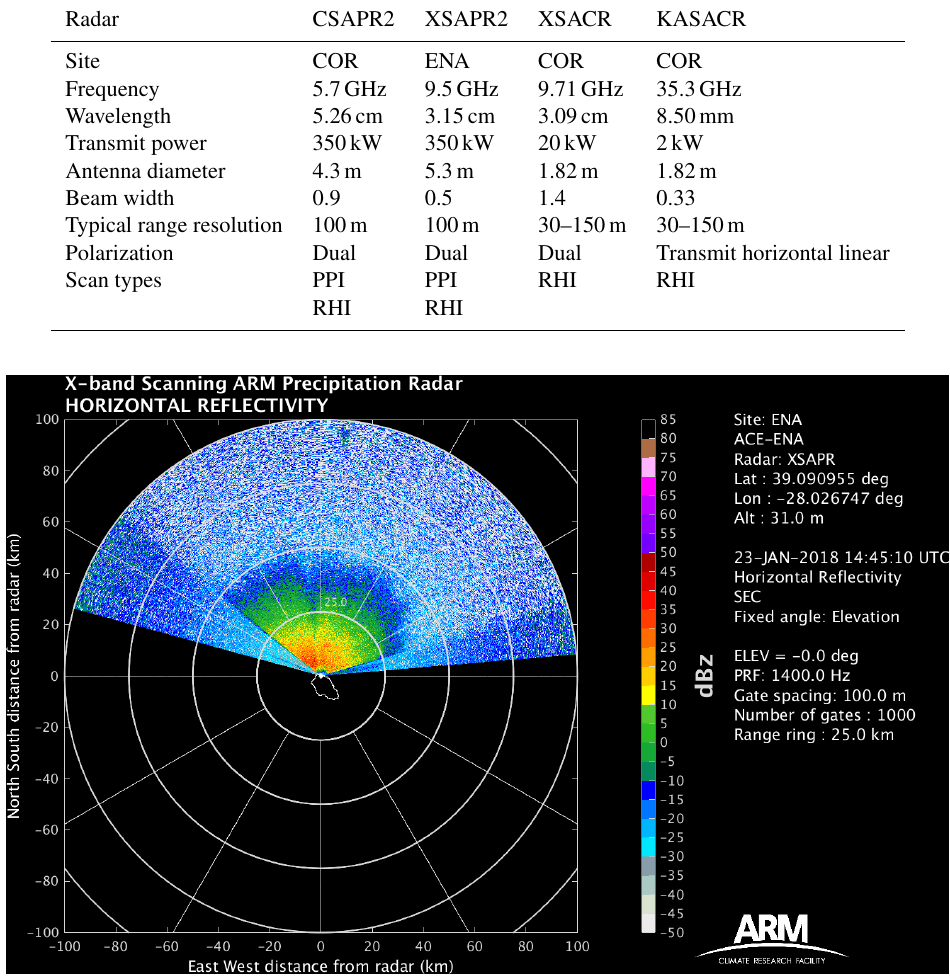
Figure 1. The Eastern North Atlantic XSAPR2 PPI from 23 January 2018 at 14:45:10UTC. The radar returns in the northern sector near the radar are sea clutter, not precipitation. The sea clutter varies day to day, with wind conditions presenting a challenge for the traditional RCA algorithm. The southern sector is not scanned due to mountain blockage as shown by the outline of the